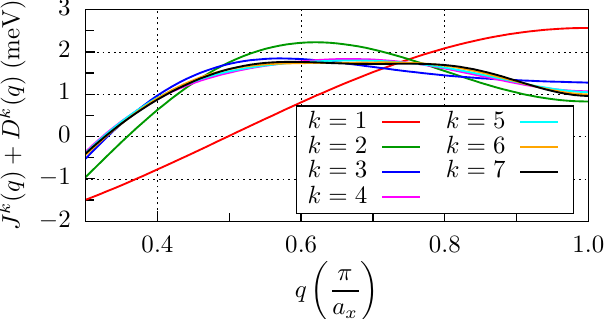
Figure 5. Side view of the ground state of the Fe chains along the x direction. The spin configurations of the Fe x 5, x 10, and x 15 chains are shown. With increasing x coordinate, a clockwise rotation of the spins is observed for all chain lengths.